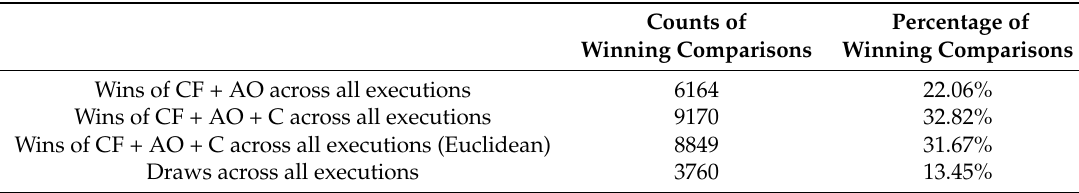
Table 11. Comparison between the recommendations given by the user-based CF algorithm with an average aggregation operator against the user-based CF with an average aggregation operator and the Smart POIs’ categories.